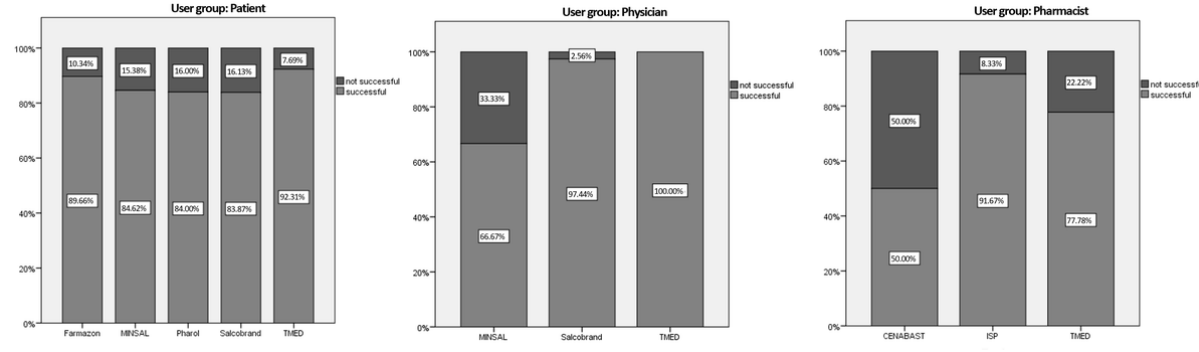
Figure 3. Binary task success rates for online consumer medication information systems: successful (light) and not successful (dark). CENABAST: